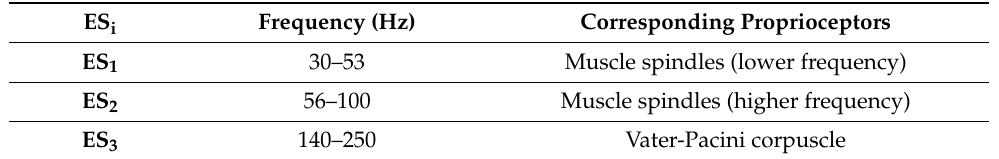
Table 2. Lists of names of each ES, frequency of local vibratory stimulation, and corresponding